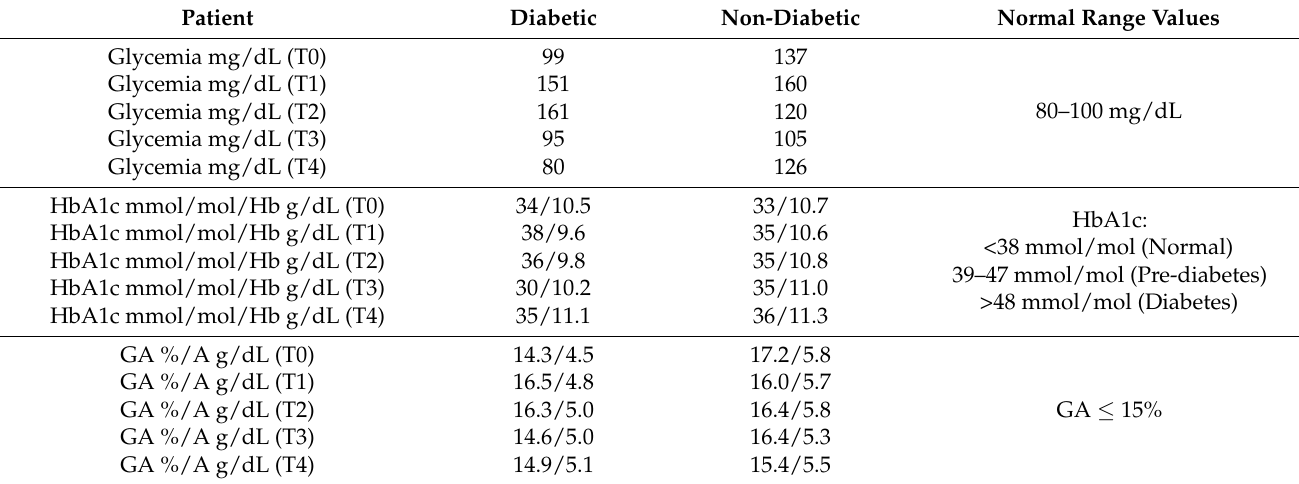
Table 3. Biomarkers of glyco-metabolic status in each time point of the study. Abbreviations: A, albumin; GA, glycated albumin; HbA1c, glycated